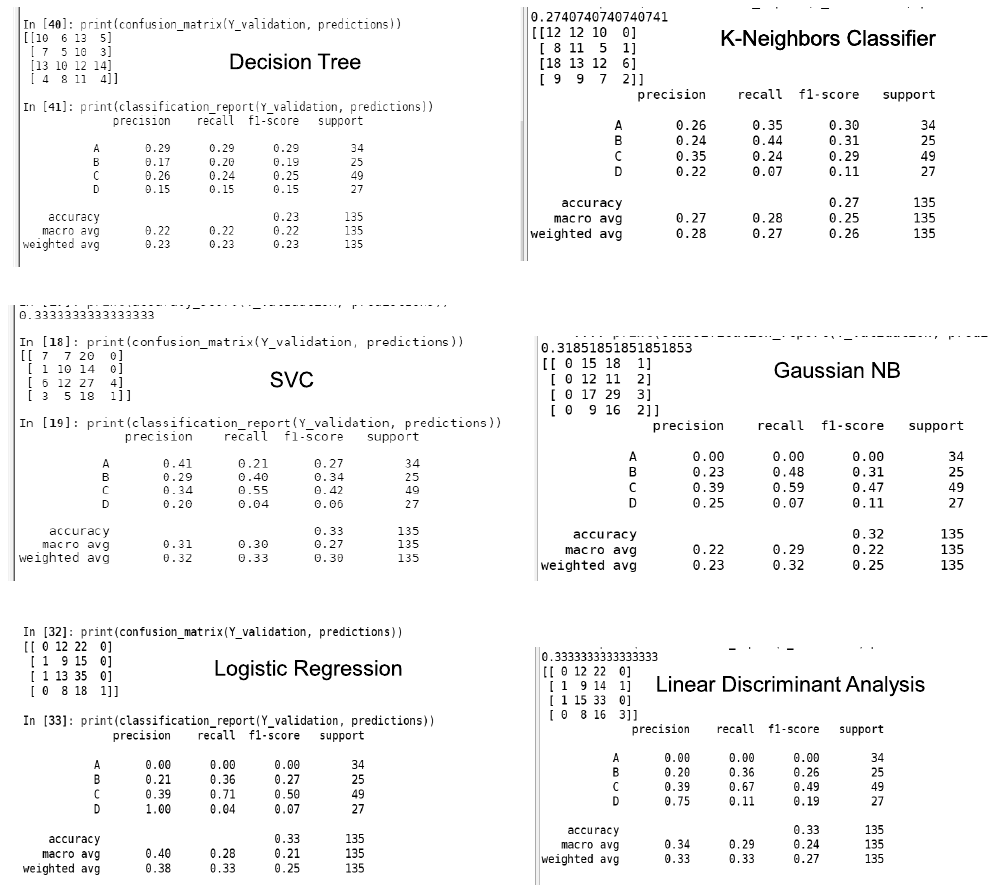
Figure 6. Performance shown by the considered algorithms in the first